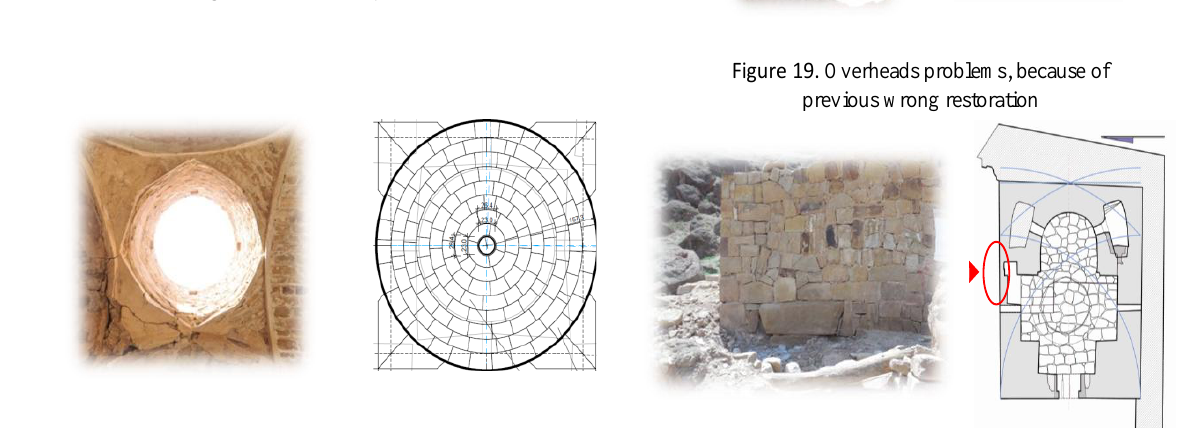
Figure 15. Incorrectly materials